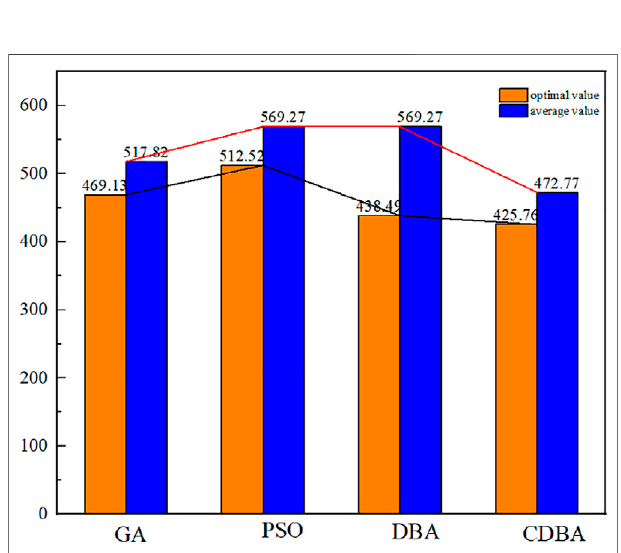
FIGURE 2 | Algorithm performance comparison experiments.